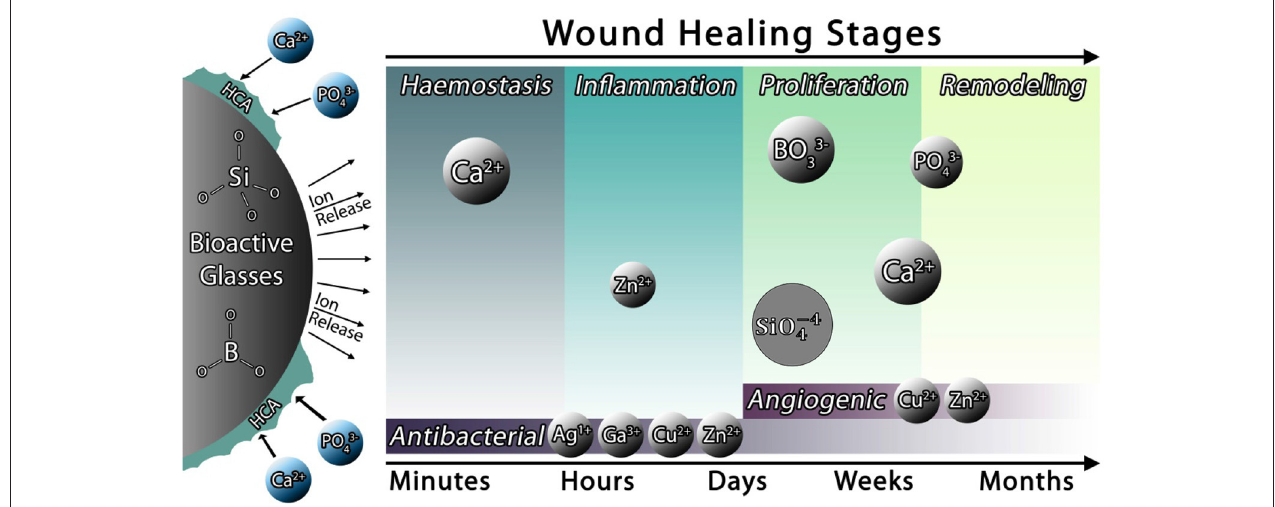
FIGURE 1 | The release of some metal ions from BGs into the surrounding environment has a positive effect on wound healing. Reproduced with some modifications from Naseri et al.